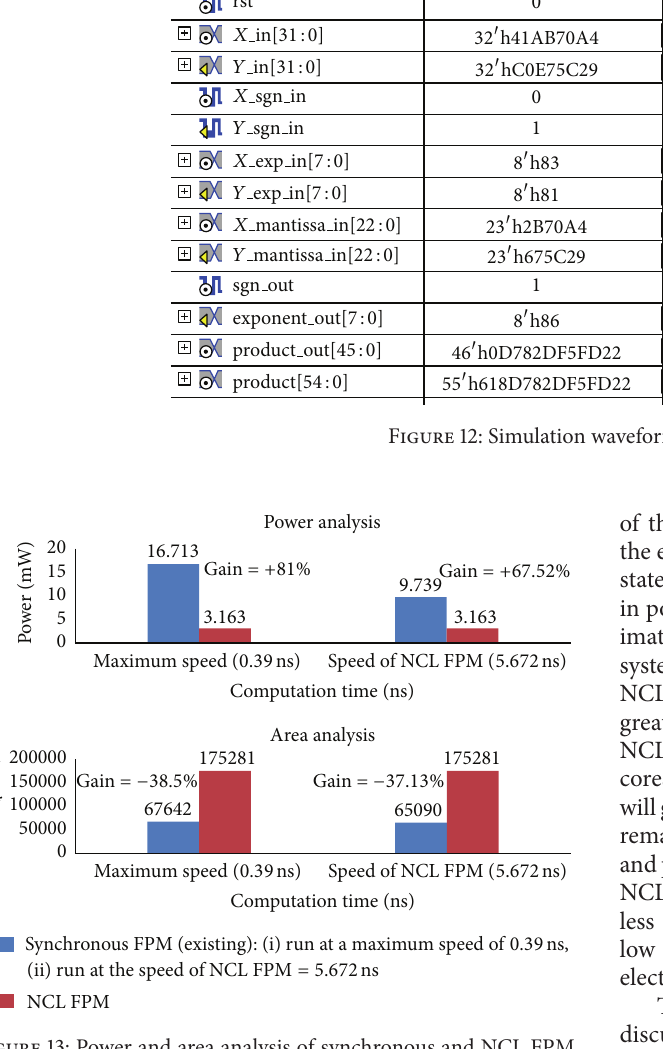
Figure 13: Power and area analysis of synchronous and NCL FPM